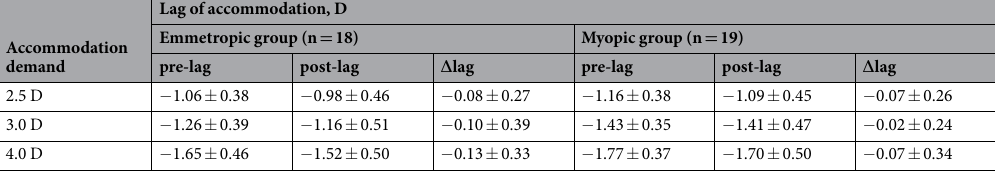
Table 3. Training effects in multifocal lens wear. Lag of accommodation before (pre-lag) and after the biofeedback training (post-lag) and the training effect ( Δ lag = pre-lag − post-lag) in the two study groups while wearing multifocal contact lenses (mean ± SD). Negative values for Δ lag indicate an improvement of accommodation accuracy after training.